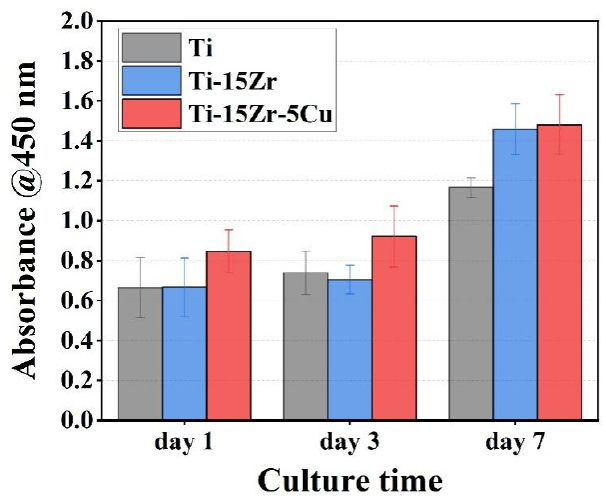
Figure 8. OD values of MC3T3-E1 cells co-cultured with the commercial pure Ti, the Ti15Zr alloy and the ultrafine-grained Ti15Zr5Cu alloy.